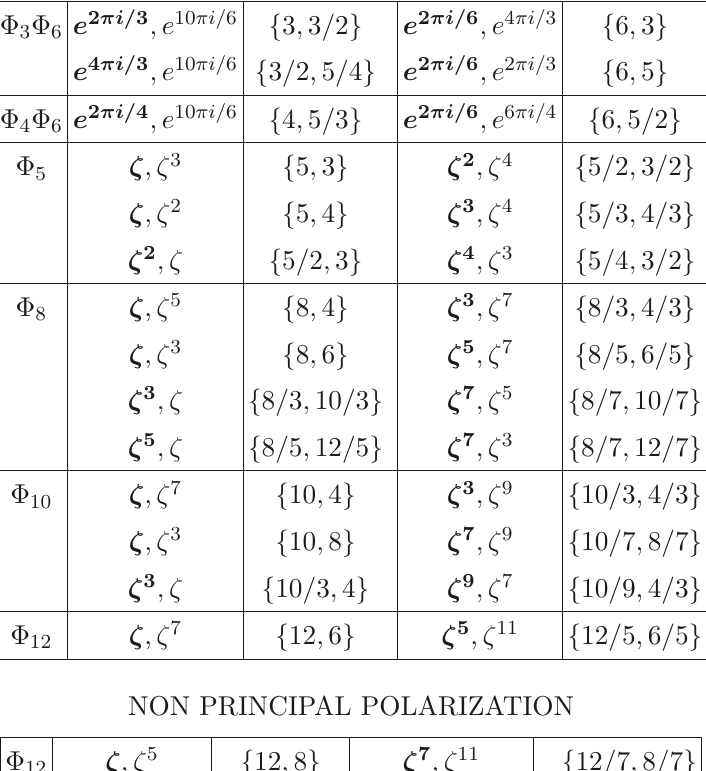
Table 5 . List of inequivalent embeddings of regular finite cyclic subgroups of Sp(4 , Z ) that lead to dimensions ∆ 1 , ∆ 2 Ξ(2) 2 . For the characteristic polynomial Φ d , ζ stands for the standard { } ∈ primitive d -root, ζ = e 2 πi/d . The boldface root is the one associated with the non-zero period a ∗ b along the regular ray. The dimension of the operator spanning the ray M ∗ is always the first one in the ordered pair ∆ 1 , ∆ 2 { }